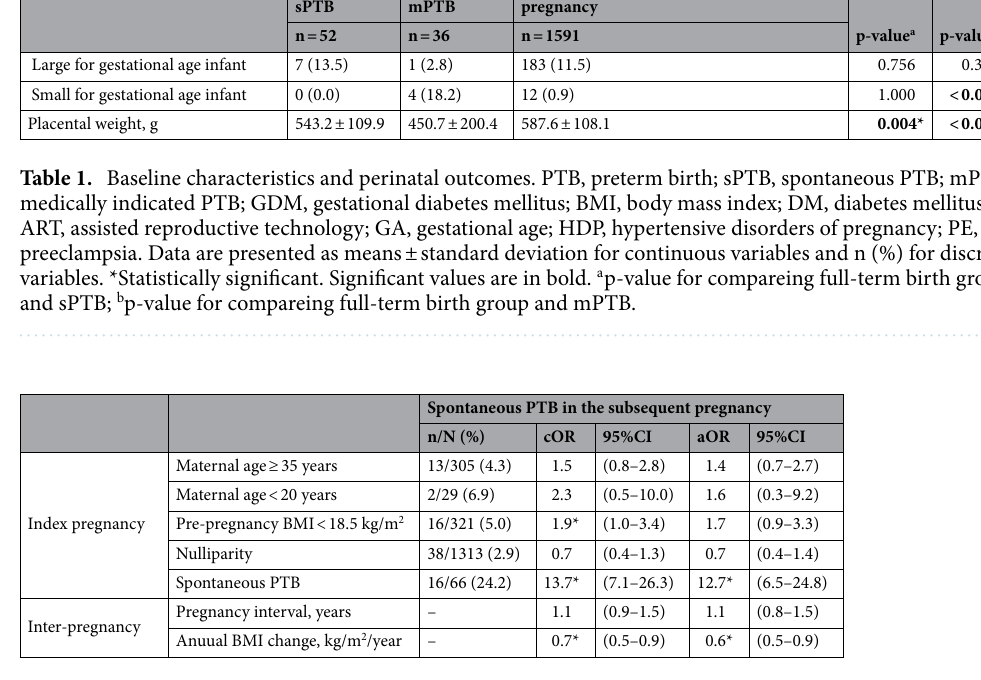
Table 2. Univariable and multivariable logistic regression analysis of variables potentially associated with sPTB in the subsequent pregnancy (n = 1643). n/N: The number of sPTB events in the subsequent pregnancy/ the number of patients for each variables; cOR, clude odds ratio; aOR, adjusted OR; CI, confidence interval; BMI, body mass index; PTB, preterm birth. *Statistically significant.